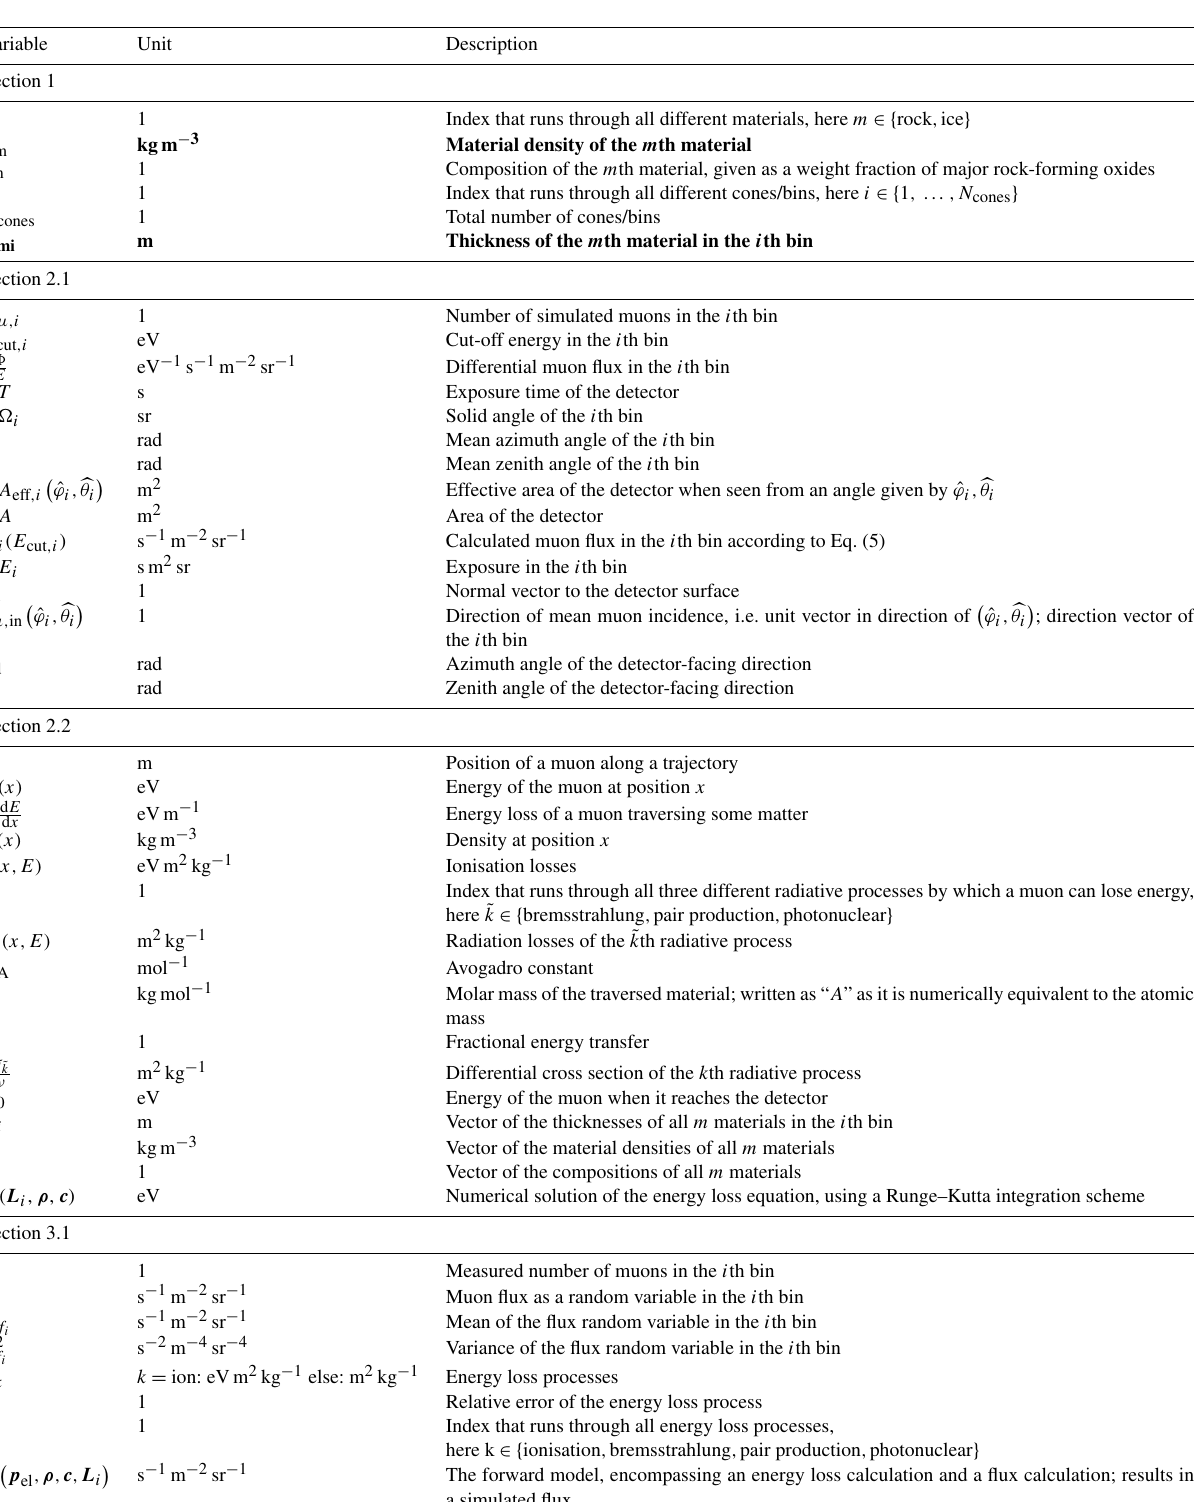
Table 1. List of variables used in this work. Parameters are grouped into sections where they are introduced first. Parameters that are sought for muon tomography (in our case and also in general) are highlighted in bold